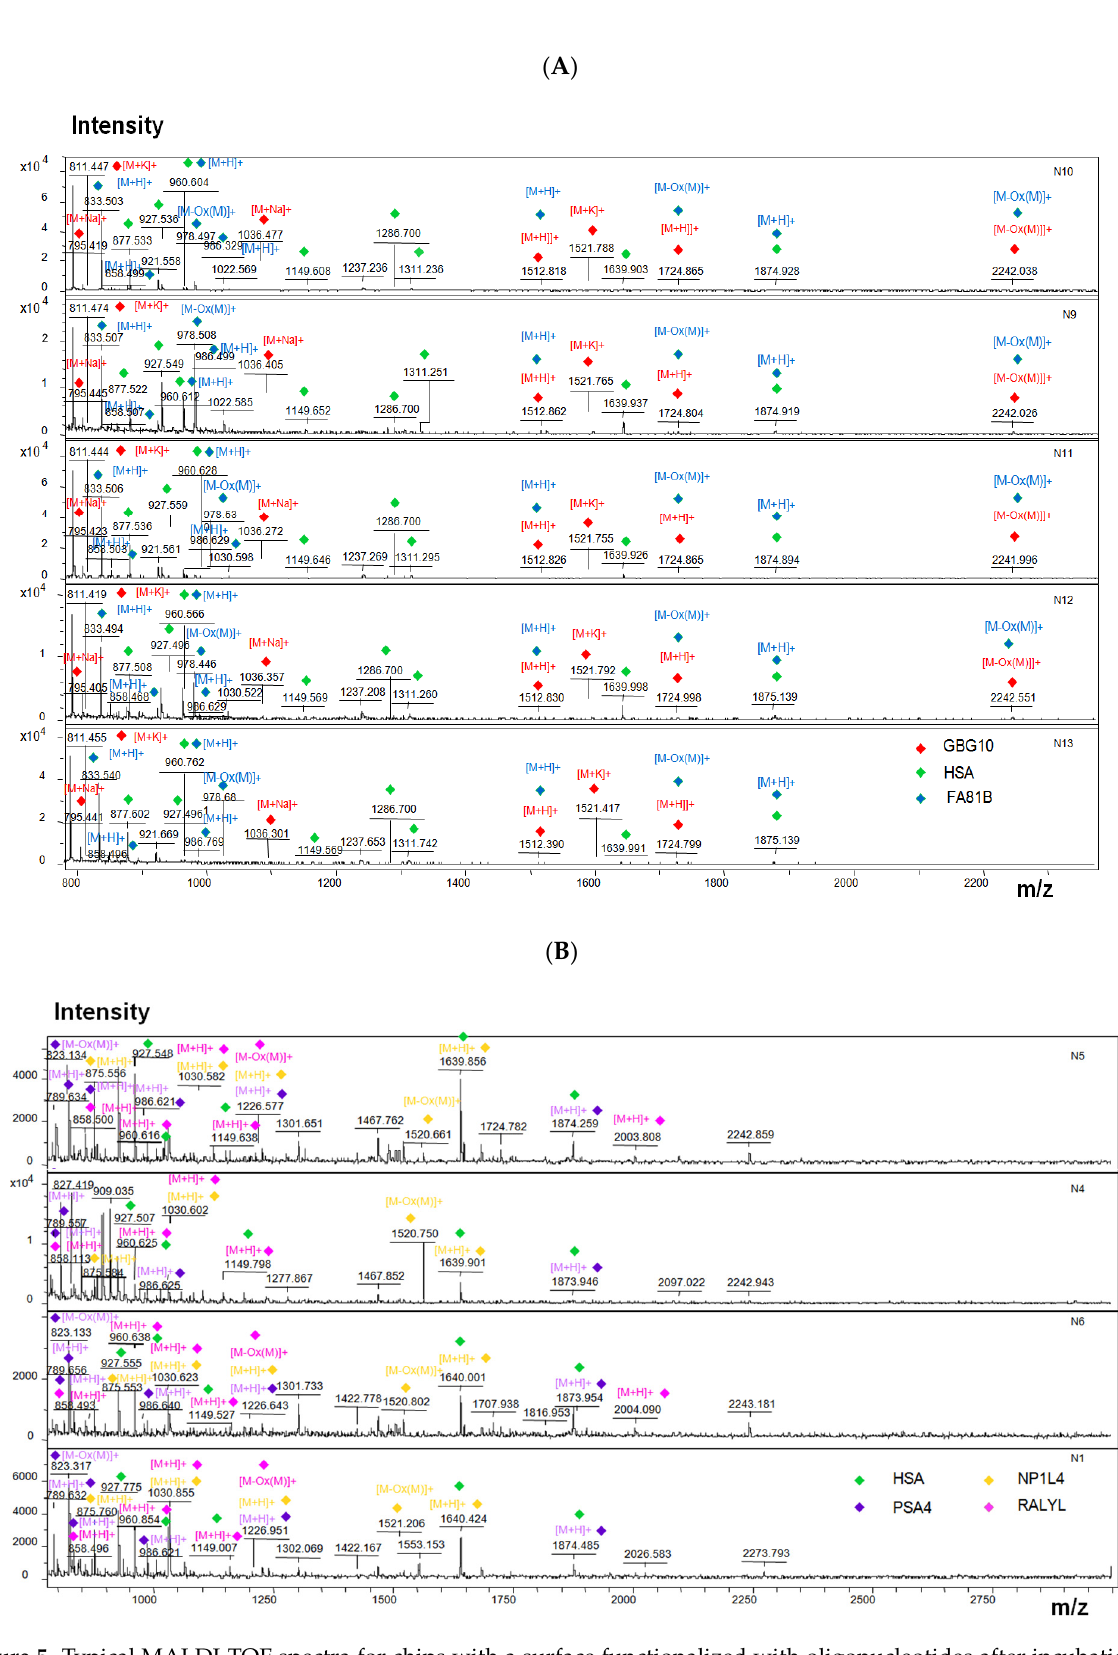
Figure 5. Typical MALDI-TOF spectra for chips with a surface functionalized with oligonucleotides after incubation in serum samples from children with ASD ( A ), or in serum of apparently healthy study participants ( B ). Coloured markers indicate revealed proteins: [M + H] + indicates intact protein peptide, [M + K] +/[M + Na] + indicates intact peptide adduct, [M-Ox (M)] + indicates intact peptide taking into account a post-translational modification–methionine oxidation.